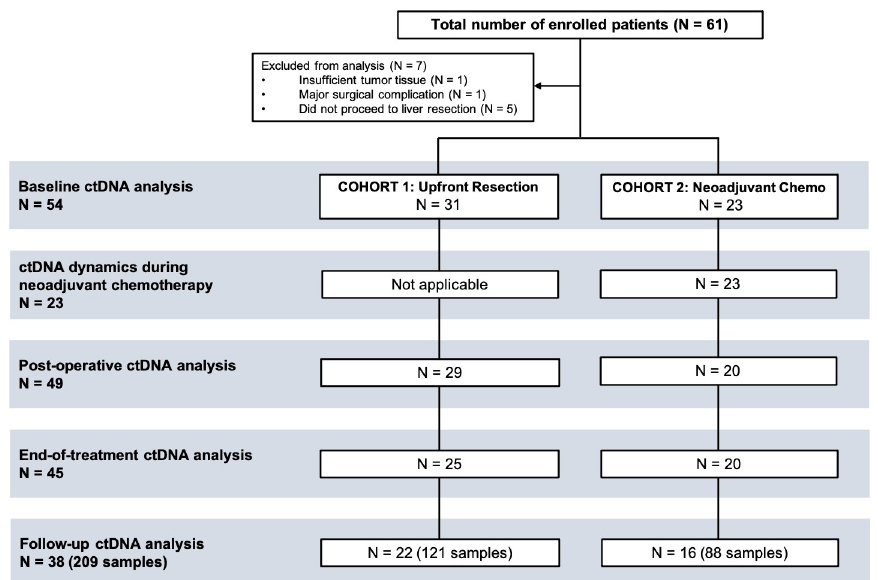
Fig 2. Patient enrolment and samples included in the analyses. Of the 61 enrolled patients, a total of 54 were included in the analysis. Five of these 54 patients who had a baseline blood draw did not have blood collection